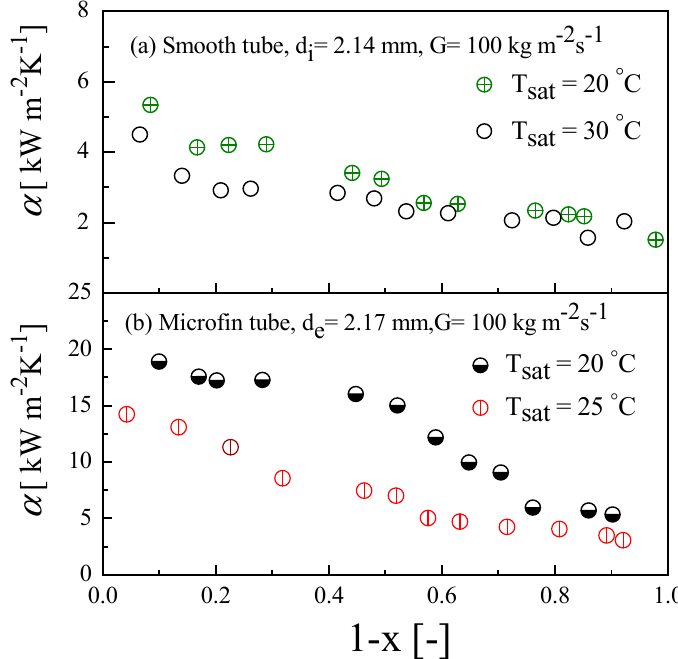
Figure 12. Effect of saturation temperature on condensation heat transfer coefficient: ( a ) smooth tube; and ( b ) microfin tube.